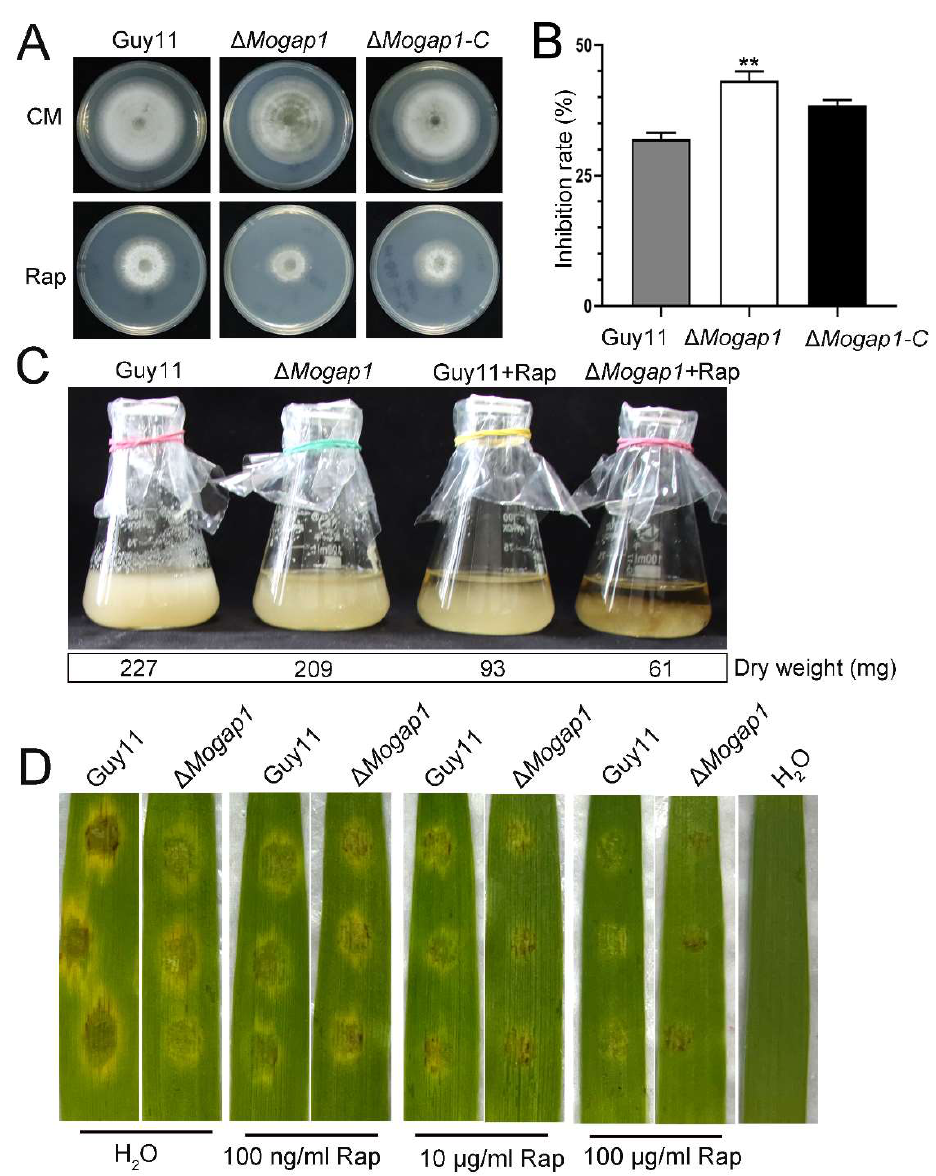
Figure 3. MoGap1 responses to rapamycin stress. ( A ) The growth of Guy11, Δ Mogap1 , and Δ Mogap1- C for 8 days of culture on CM and Rap for 8 days, respectively. ( B ) The inhibition rates of rapamycin in Guy11, Δ Mogap1 , and Δ Mogap1-C calculated by measuring the growth diameters, which were significantly different between MoGap1 and Guy11 (** p < 0.01). ( C ) The growth rate was observed in CM liquid medium. The dry weights of Guy11 and Δ Mogap1 were calculated after being cultured in CM liquid medium for 2 days. ( D ) Virulence detection in Δ Mogap1 mutant. The conidia (1 × 10 5